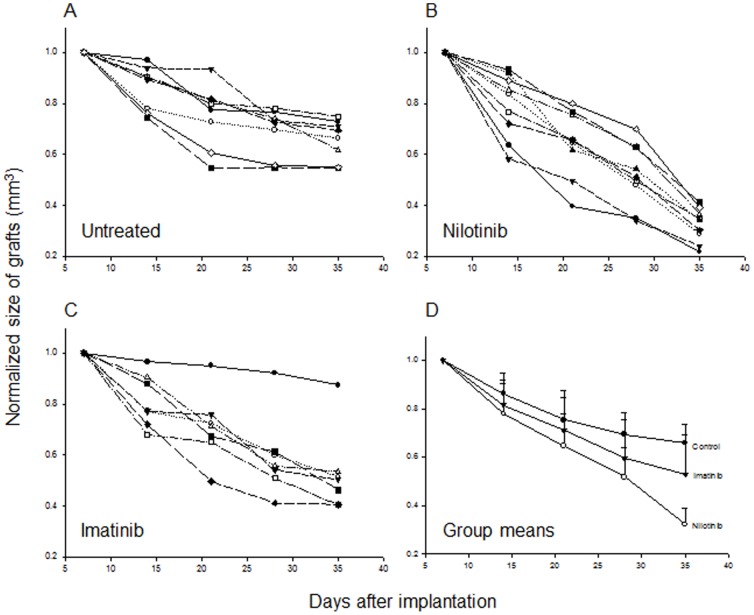
Change of xenograft size in each mouse over the 4-weeks of treatment period in the untreated (A), nilotinib (B) and imatinib (C) groups.Group-means (D) differed significantly among the three groups (P<0.05).